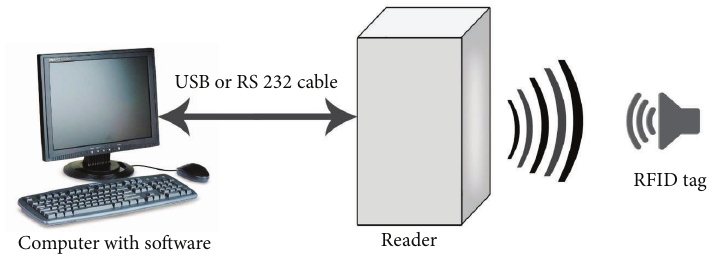
Figure 1: Block diagram of radio frequency identification (RFID) system.